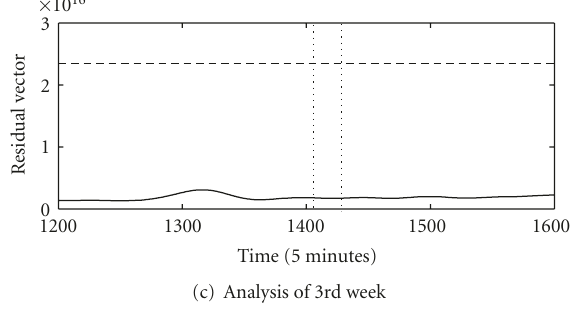
Figure 16: The detection results based on PCA.